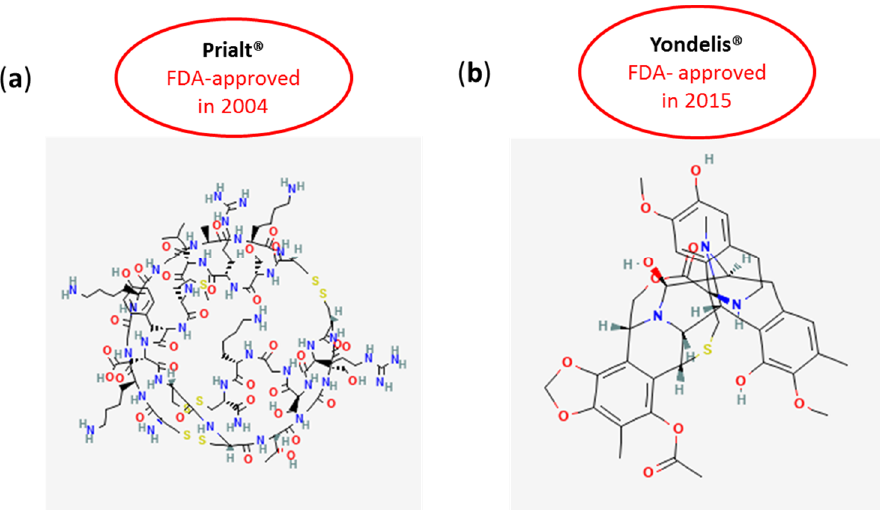
Figure 4. Chemical structures of ( a ) Prialt ® and ( b ) Yondelis ® FDA approved in 2004 and 2015, re- spectively. Chemical structures of Ziconotide (Prialt ® ; PubChem Identifier: CID 16135415) and Tra- bectedin, ET-743 (Yondelis®; PubChem Identifier: CID 108150), are from the public database Pub-